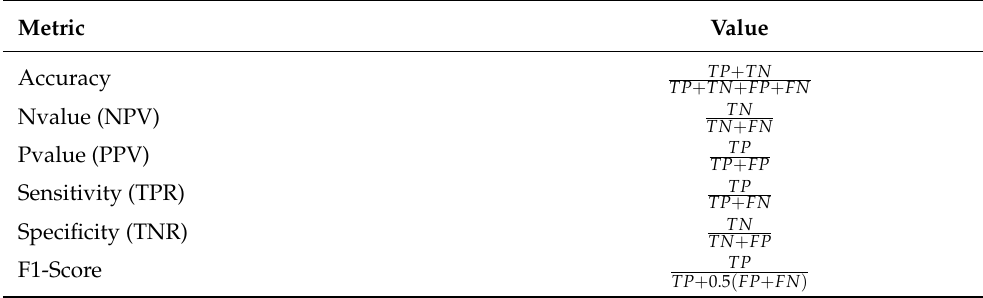
Table 2. The metrics used in evaluating the performance of the proposed optimized NN.